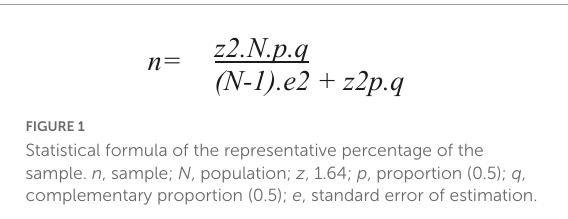
FIGURE1 Statistical formula of the representative percentage of the sample. n , sample; N , population; z , 1.64; p , proportion (0.5); q , complementary proportion (0.5); e , standard error of